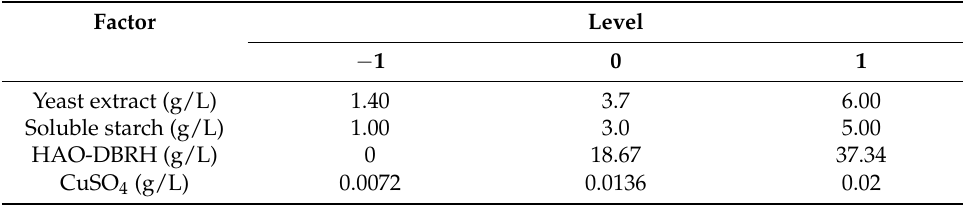
Table 1. Factors and levels in the experimental